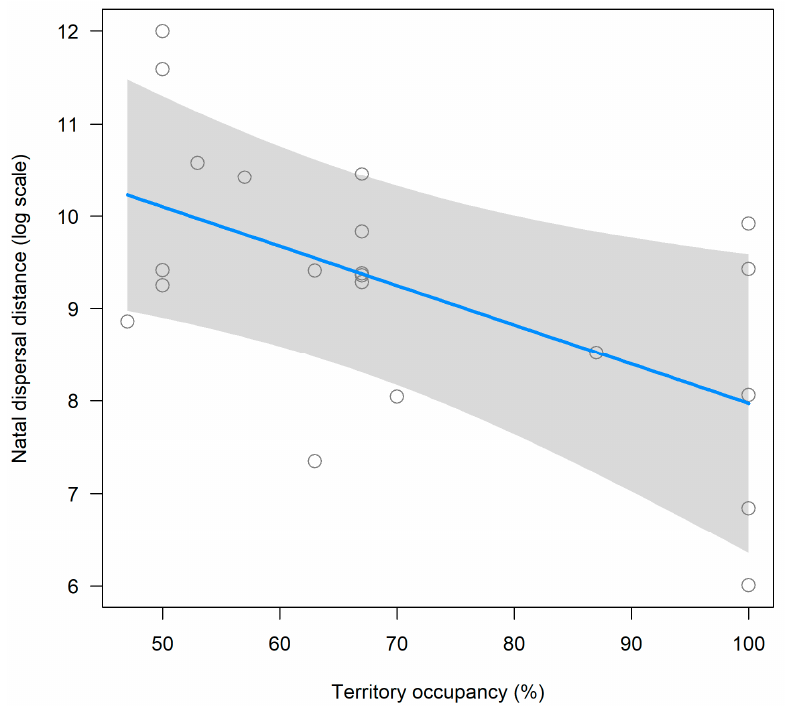
Figure 4. Partial residual plot of natal dispersal distance (km) in relation to territory occupation rate of Black-shouldered Kites ( Elanus caeruleus ) studied in southwestern Spain. The line is the prediction of territory occupation rate on natal dispersal distance while maintaining the other predictor in the model on their mean values. 95% CI are shaded in grey color.